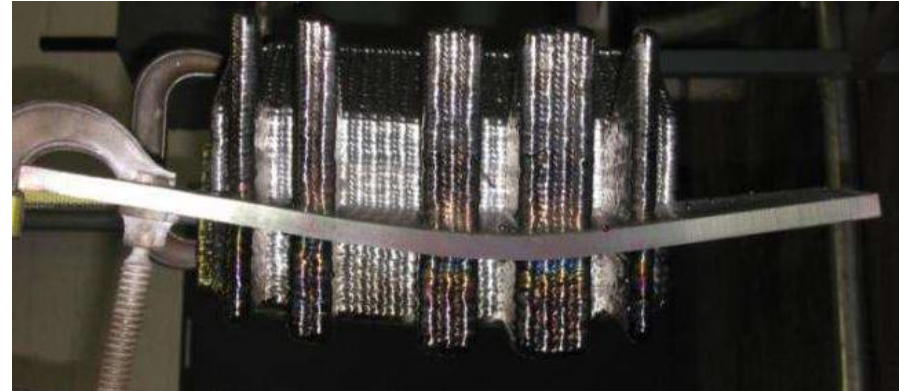
Figure 2. Distortion of NP1 fabricated using EBAM technology on a 1.27 cm plate; part geometry measures 40 cm in width and 18 cm in height. Thermal cycling and the weight of the printed material have permanently deflected the base plate as shown.